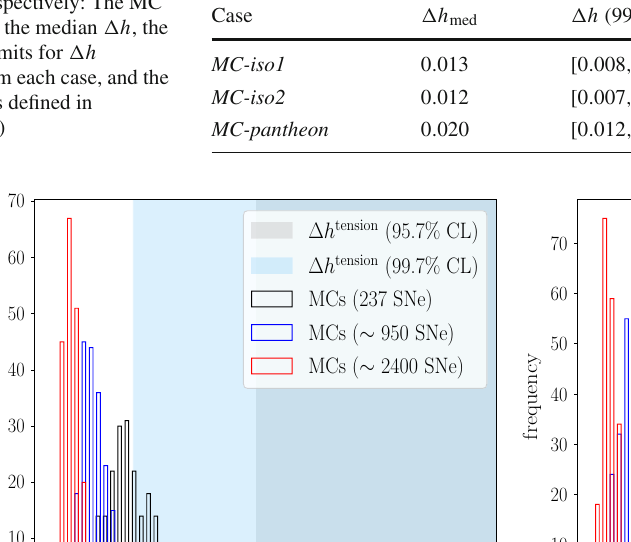
Fig. 3 Left panel: the (cid:6) h of 200 MC-iso1 realizations assuming the original number of data points, as well as for those assuming samples 4 and 10 times larger. Right panel: same as before, but for MC-iso2